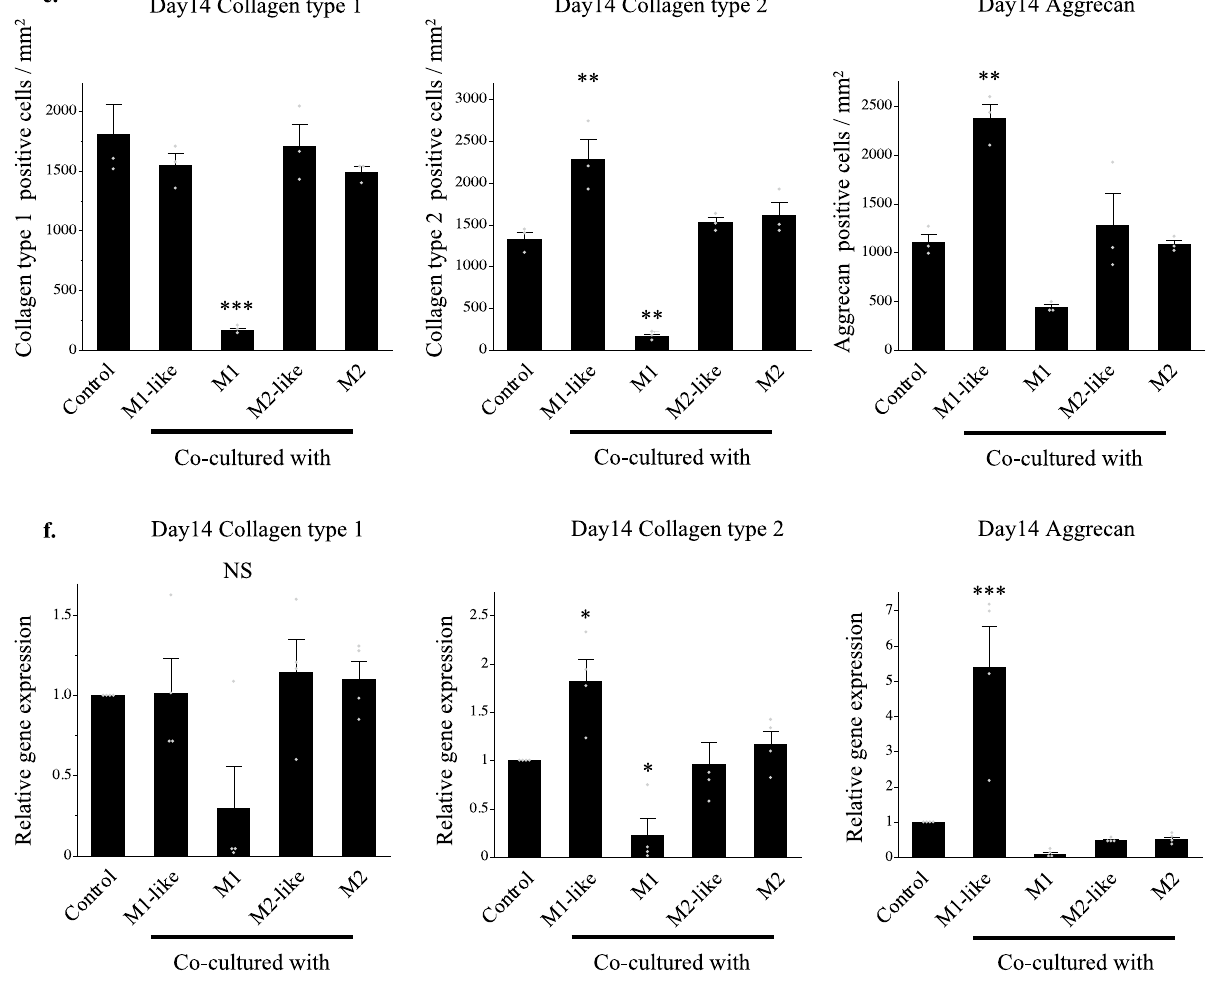
Figure 2. (e) Quantitative evaluation based on the DAB-positive cell count in immunohistochemical staining (on day 14 of co-culture). Left: Collagen type 1, Middle: Collagen type 2, Right: Aggrecan. **P < 0.01, ***P < 0.0001. NS: Not significant. The data are presented as the mean ± SEM (n = 3). (f) Gene expression analysis using RT-PCR (on day 14 of co-culture). Left: Collagen type 1, Middle: Collagen type 2, Right: Aggrecan. The data are presented as the mean ± SEM (n =